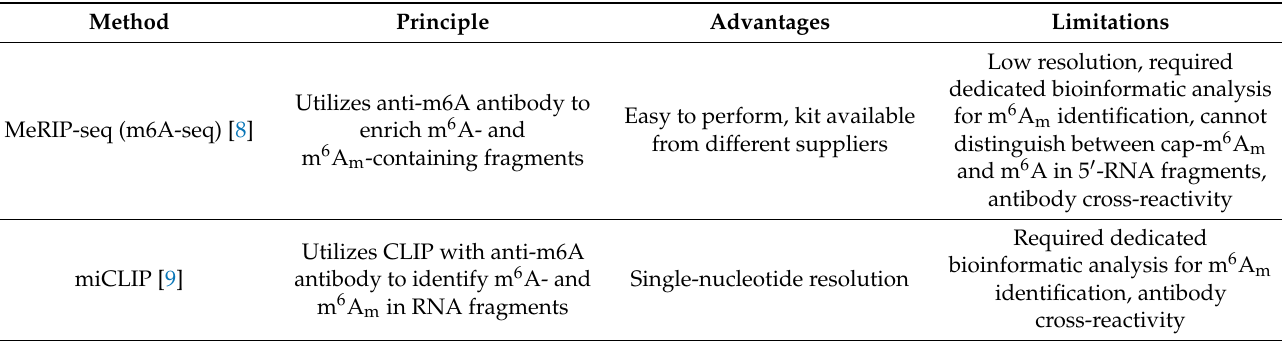
Table 1. Methods utilized for m 6 A m